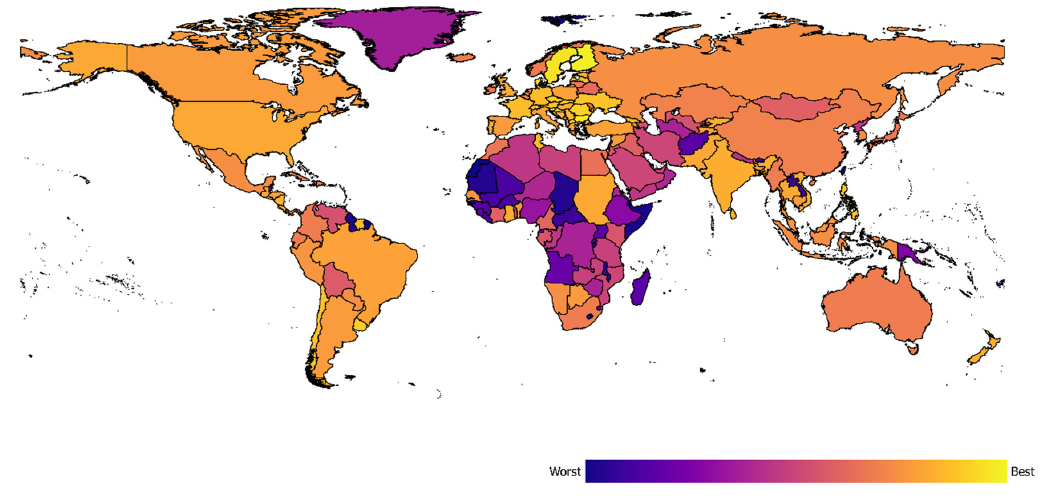
Figure 4. Global view on the diversity dimension.